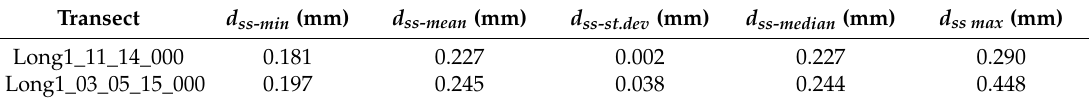
Table 6. Maximum suspended grain size d ss . Legend: d ss-min = minimum value of the maximum suspended grain size; d ss-mean = mean of the maximum suspended grain size; d ss-st.dev = standard deviation of the maximum suspended grain size; d ss-median = median of the maximum suspended grain size; d ss-max = maximum value of the maximum suspended grain size.